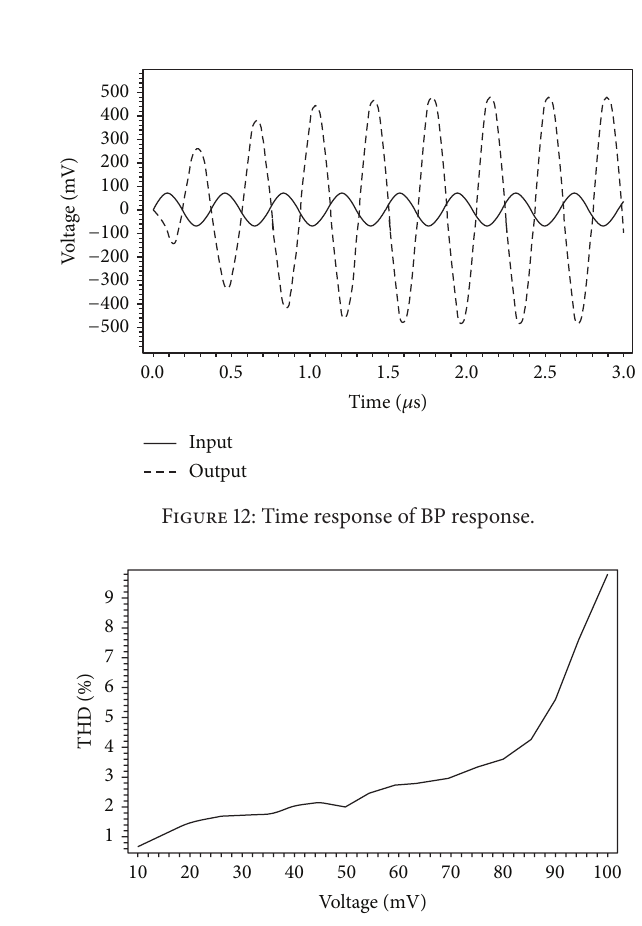
Figure 13: THD variation with respect to input sine wave